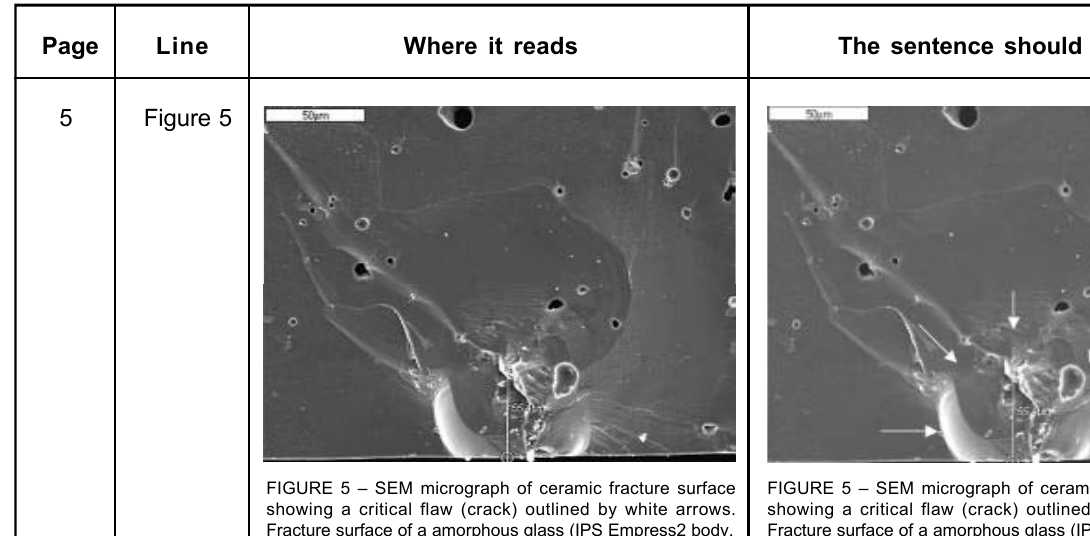
2004FIGURE 5 – SEM micrograph of ceramic fracture surface showing a critical flaw (crack) outlined by white arrows. Fracture surface of a amorphous glass (IPS Empress2 body, Ivocalr AG, Schaan, Liechtenstein; note the tailed fracture markings (top right) pointing toward the crack origin; measured line represents the semiminor axis a= 55µm (500x). From Della Bona, et al. 20 , 2004